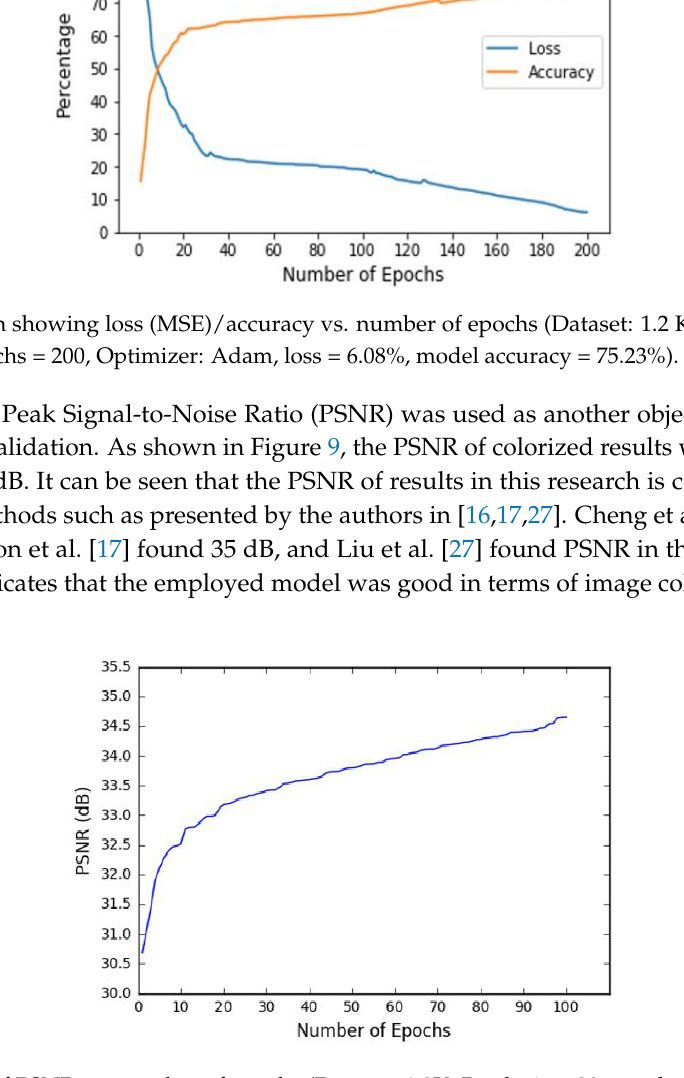
Figure 9. Plot of PSNR vs. number of epochs (Dataset: 1.2K, Batch size: 20, number of epochs: 100, Optimizer: